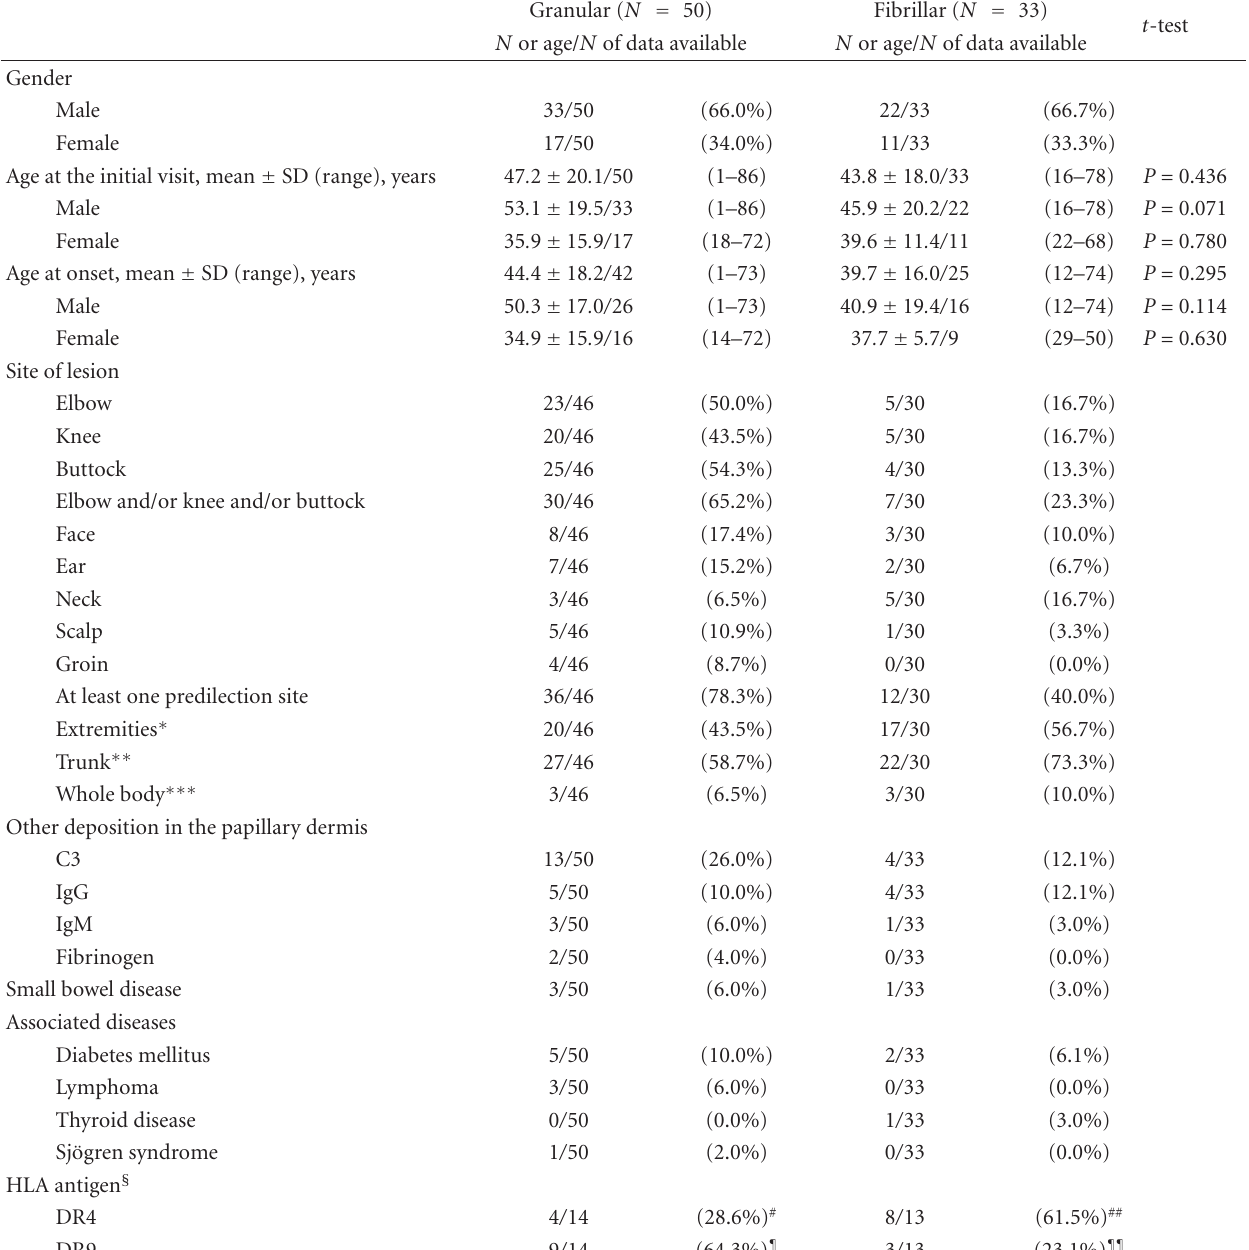
Table 2: Comparison of granular and fibrillar deposition